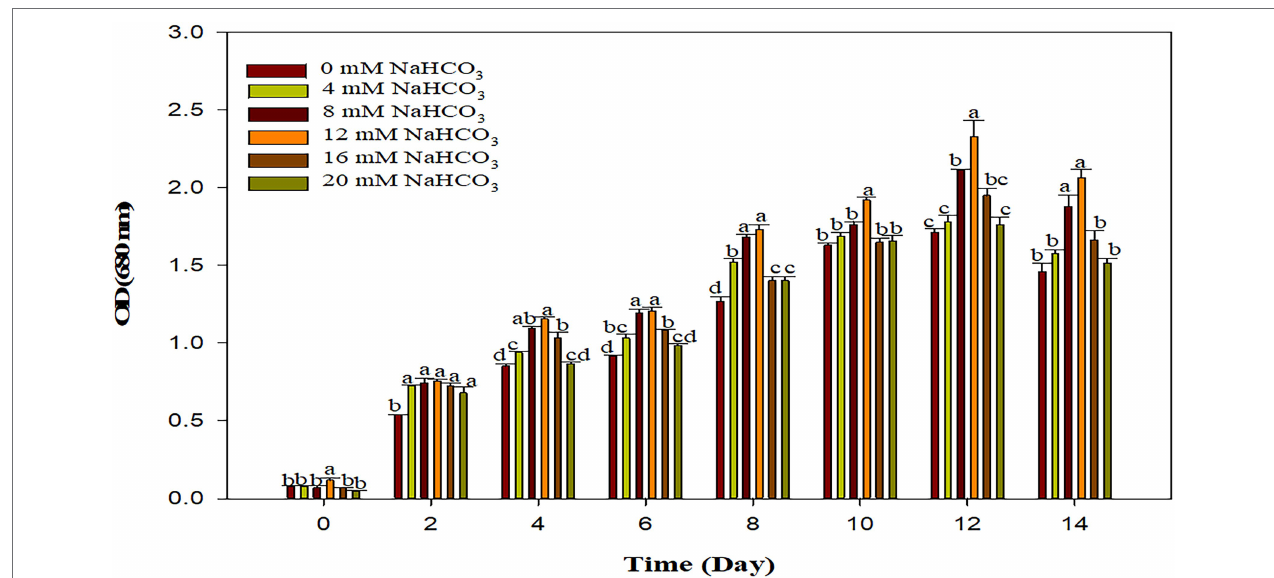
FIGURE 4 | Effect of different sodium bicarbonate concentrations with time (day) on growth pattern of microalga Scenedesmus sp. BHU1. Bars are mean ± SE of three replicates. Bars adhered with different alphabets (a, b, c, and d) are statistically significant at p < 0.05 (Tukey’s-b post hoc